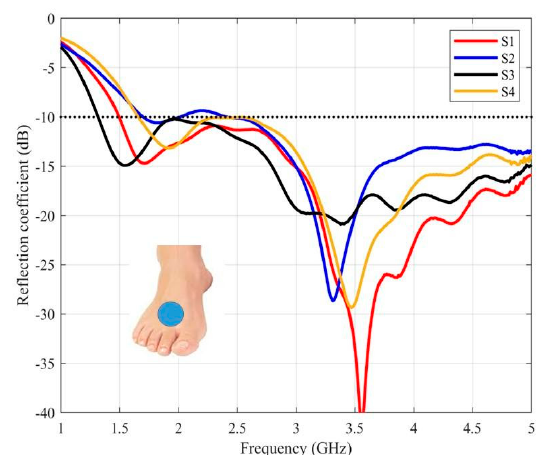
Figure 8. The measured reflection coefficients of the purposed antenna placed on the instep.